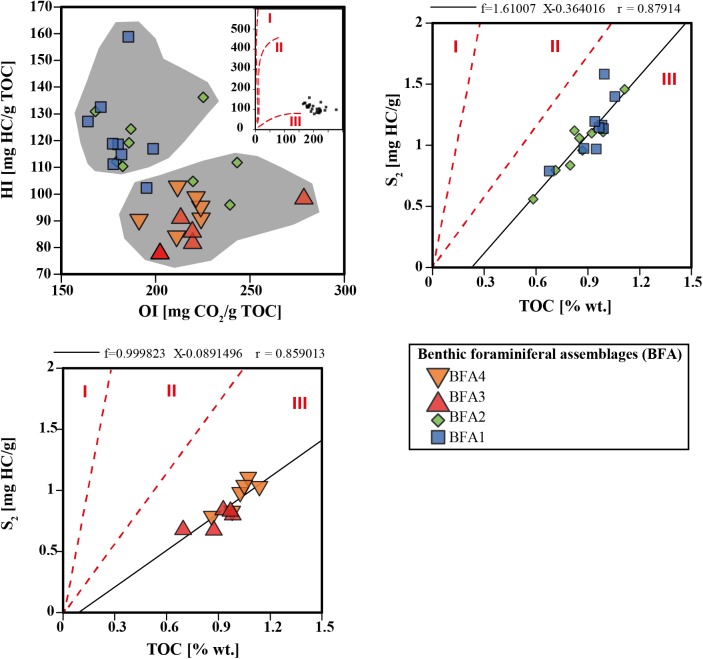
Pseudo-Van Krevelen HI versus OI plots showing the distribution of samples from core TTR17-401G and S2 versus Total organic carbon (TOC) diagrams for samples BFA1-BFA2 and BFA3-BFA4.Regression curves are also shown for each diagram. Boundaries between the kerogen type fields are from Langford and Blanc-Valleron [80].